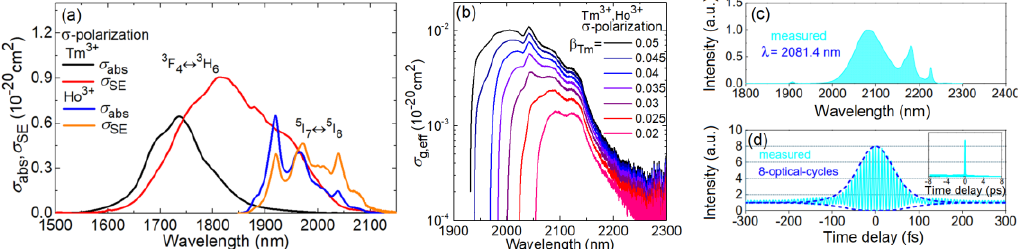
Fig. 1. (a,b) Spectroscopy of Tm 3+ and Ho 3+ ions in the disordered CALGO crystal: (a) absorption, σ emission, σ SE , cross-sections for the 3 F 4 ↔ 3 H 6 Tm 3+ and 5 I 7 ↔ 5 I 8 Ho 3+ transitions around 2 μm, (b) gain profiles for a Tm 3+ , Ho 3+ codoped crystal plotted in a semi-log scale accounting for the long-wave vibronic emission. Light polarization: σ; (c,d) KLM Tm:(Lu,Sc) 2 O 3 sesquioxide ceramic laser: (c) optical spectrum and (b) interferometric autocorrelation